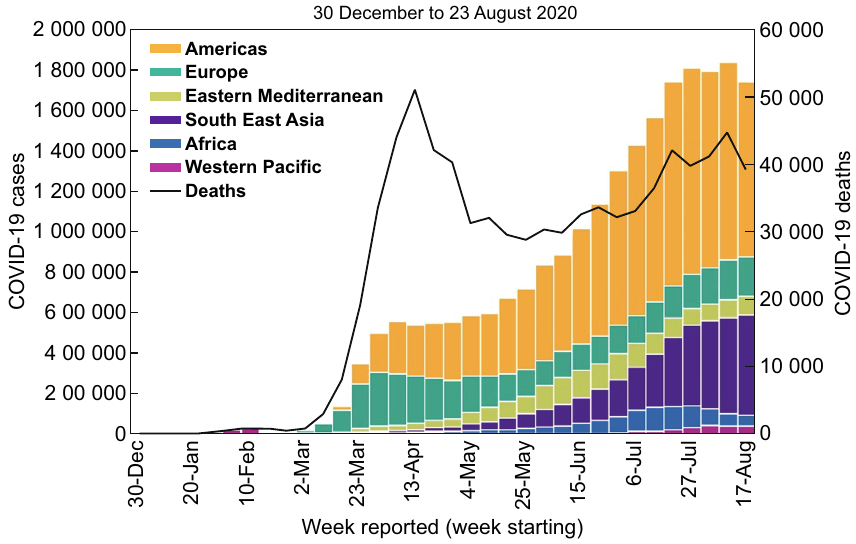
Fig. 1 Epidemic chart of confirmed COVID‑19 up to August 23, 2020. Used with permission from Ref. [8]. Copyright 2020 World Health